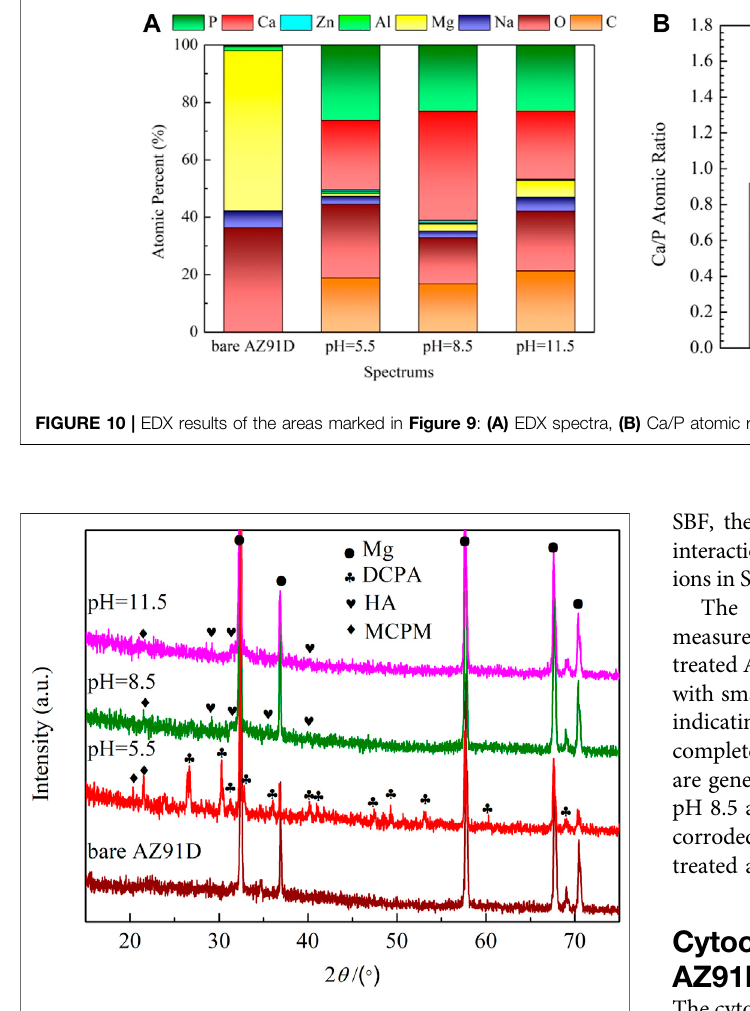
FIGURE 11 | XRD patterns of samples after electrochemical